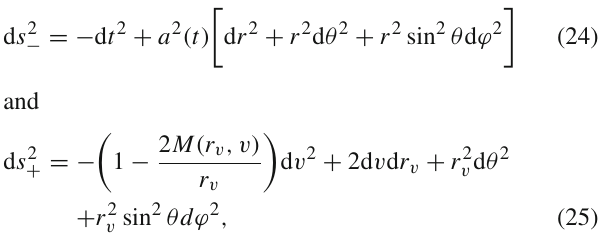
Fig. 1 a ( t ) vs. t for various values of p